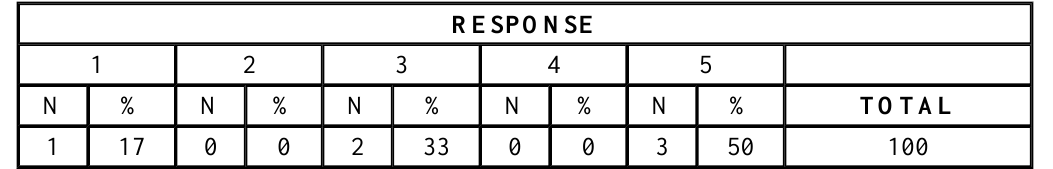
Table 3 Organizations currently implementing BI practices and